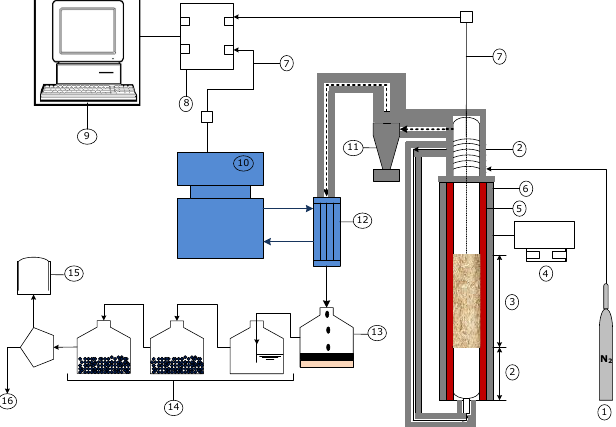
Figure 1. Experimental set-up. (1) Nitrogen cylinder; (2) nitrogen preheating sections; (3) pyrolysis section; (4) furnace controller; (5) heater; (6) insulator; (7) thermocouples; (8) data logger; (9) computer; (10) water chiller; (11) cyclone; (12) condenser; (13) bio-oil collector; (14) gas scrubber; (15) gas sampling bag; (16) gas venting.